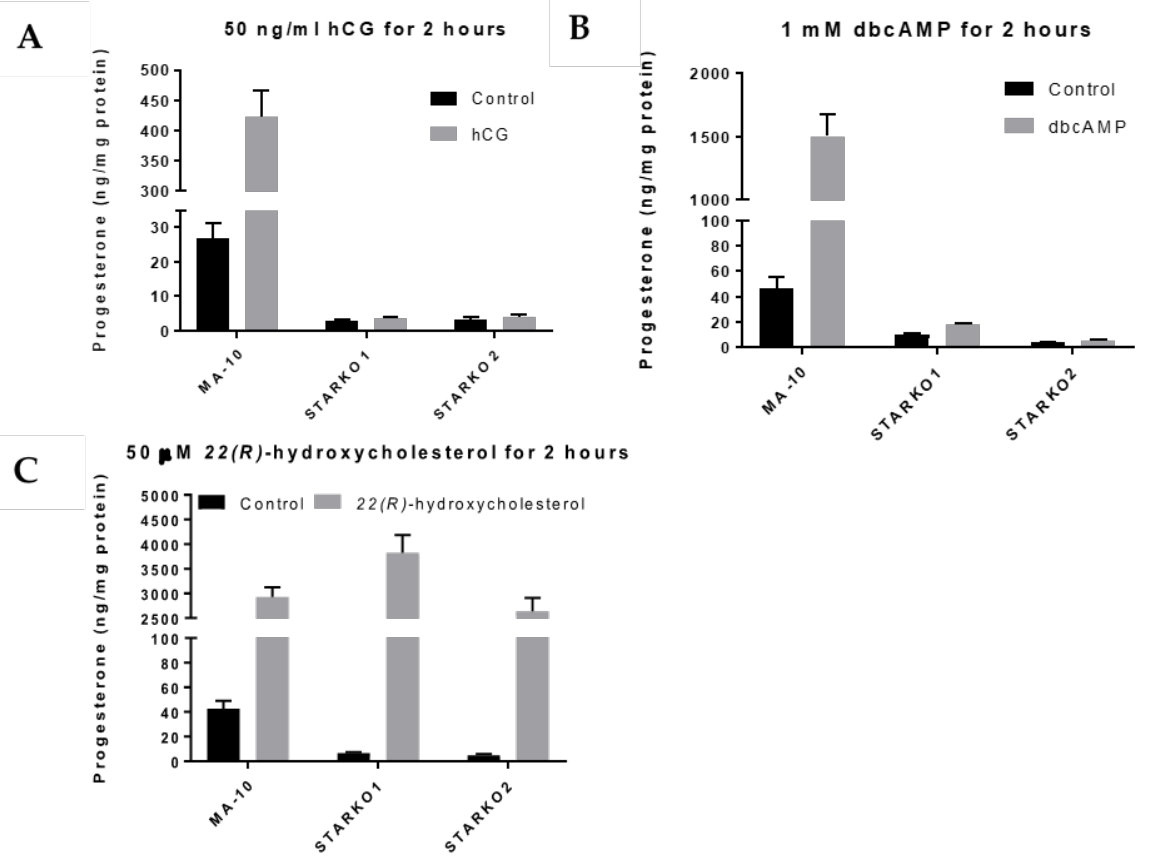
Figure 3. Progesterone production by wild-type MA-10 and STAR KO cell lines in response to stimulus. ( A ) ELISA analyses of progesterone levels in cell media following stimulation with 50 ng/mL hCG for 2 h. ( B ) ELISA analyses of progesterone levels in cell media following stimulation with 1 mM dbcAMP for 2 h. ( C ) ELISA analyses of progesterone levels in cell media following stimulation with 50 μM 22( R )-hydroxycholesterol for 2 h. Data are shown as the mean ± SEM ( n = 3).